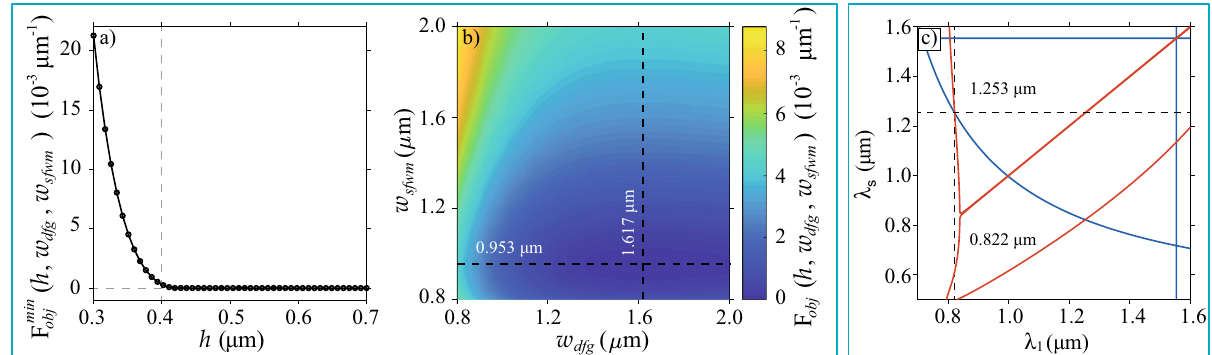
Figure 4. Method for simultaneous SFWM and DFG phasematching. ( a ) The minimum value of the objective function in terms of the core height h , when the widths of the two waveguides are allowed to vary. ( b ) Value of 0.7 µ m in terms of the two waveguide widths. ( c ) Phasematching contours for the objective function for h = 0.7 µ m, w 0.953 µ m and w 1.617 µ SFWM (red) and DFG (blue), obtained with parameters h sfwm = dfg = =